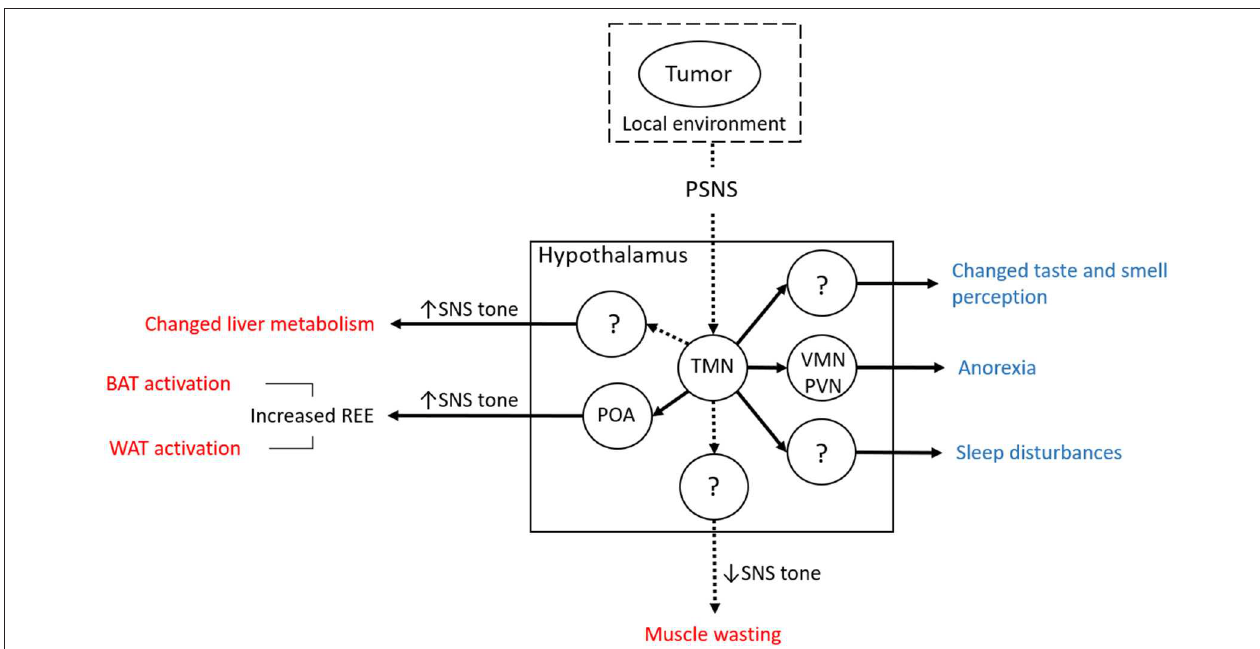
FIGURE 2 | Overview of the hypothesis concerning the involvement of the neuronal part of the histaminergic system in cancer cachexia. Muscle wasting is suggested to involve the loss of SNS tone. The mechanism and the time of onset in the course of cancer cachexia is still not clear, although the switch from increased to reduced neuronal histamine signaling might delineate the late phase (muscle wasting). The notion of histaminergic neurons in the TMN mediating cancer cachexia is consistent with a mechanism involving the sensing of tumor-derived signals (including those reflecting changes in its local tissue environment via the PSNS). Since this mechanism does not rely on systemic inflammation as a trigger of neuroinflammation, it represents an alternative route for tumors to affect systemic metabolism and cause cancer cachexia (BAT, brown adipose tissue; POA, preoptic area; PSNS, parasympathetic nervous system; PVN, paraventricular nucleus; REE, resting energy expenditure; SNS, sympathetic nervous system; TMN, tuberomamillary nucleus; VMN, ventromedial nucleus; WAT, white adipose tissue). Solid lines originating from the TMN indicate that connections have already been shown although in other contexts than cancer cachexia. Dashed lines indicate that while there is no direct evidence, it can be inferred indirectly. Solid lines between circles (hypothalamic nuclei and the periphery, BAT and WAT) indicate that increased SNS tone has been shown to be decisive in the respective physiological context. Central effects of tumor-induced changes of neuronal histamine signaling are shown in blue font, peripheral effects in